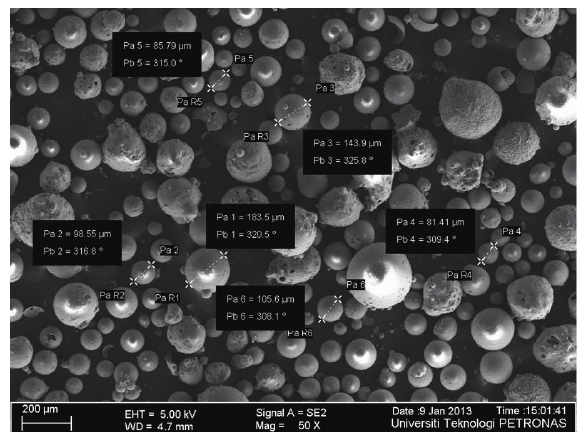
Figure 3: Microstructure of silica fume through field emission scanning electron microscope (FESEM) showing particle size dis-